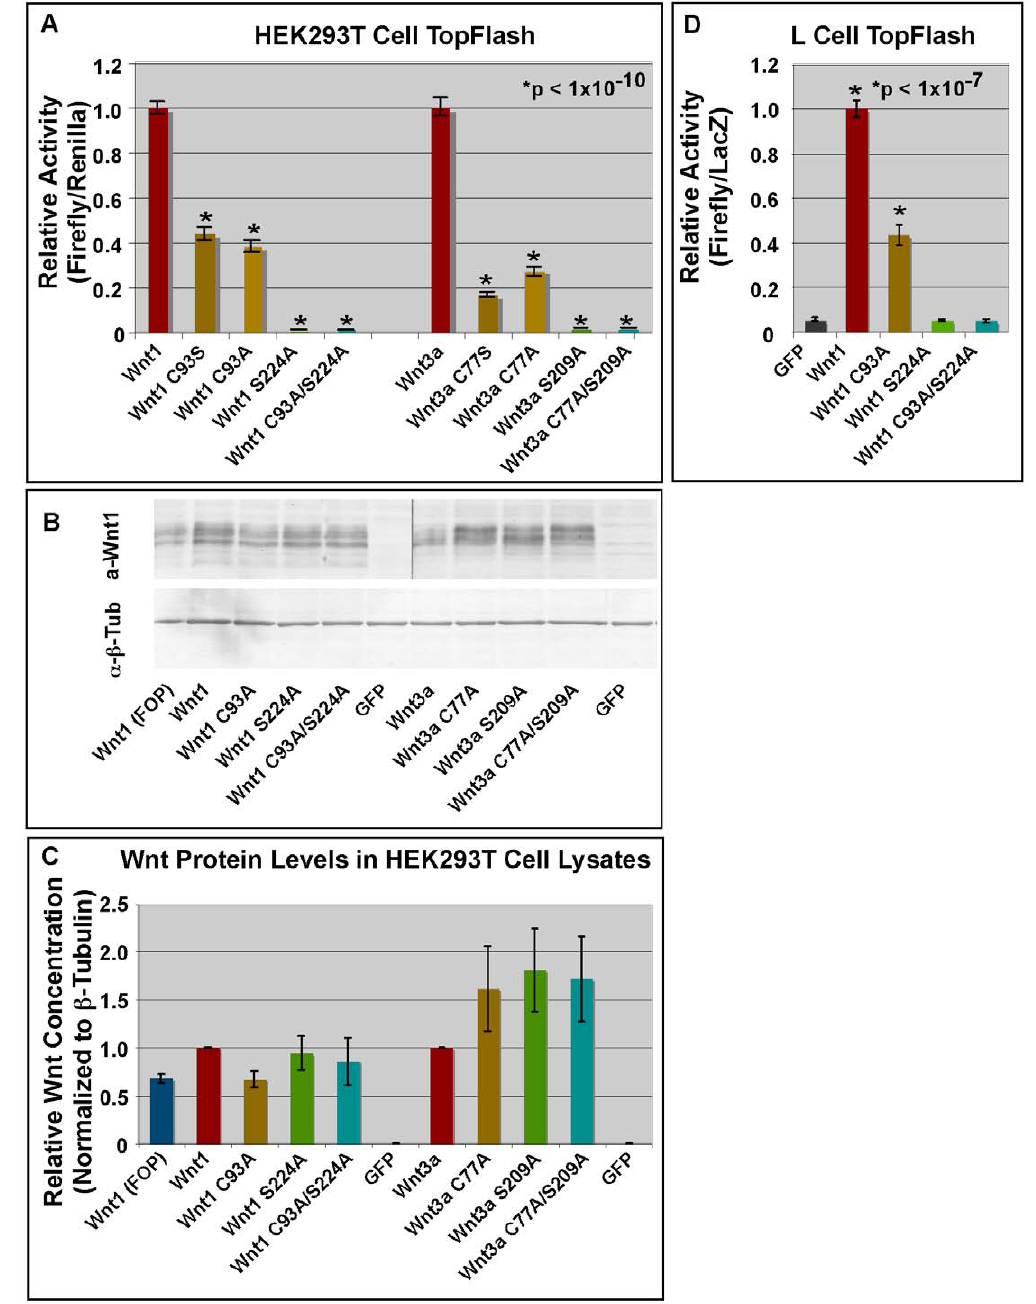
Figure 5. Wnt1 S224 is more critical than C93 for ß-catenin dependent signaling. Panel A: HEK293T cells were transfected with 8XSuperTop/FopFlash [64], renilla luciferase, and indicated pcDNA expression constructs. DNA concentrations were held constant within each series of experiments. Values shown reflect the experimental data (Firefly/Renilla) minus FopFlash (Firefly/Renilla). The relative luciferase activity of wild-type Wnt1/Wnt3a was set at 1. Single and double Wnt1/Wnt3a mutants show significantly less activity than wild-type Wnts (p , 1 6 10 2 10 ). Differences between C93S and C93A mutants are not significant nor are those between S224A and C93A/S224A. Error bars indicate standard error for at least 15 data points from 3 independent replicates. Panel B: HEK293T cells were transfected as in Panel A, lysed, subjected to SDS-PAGE, and blotted onto PVDF. Blots were probed with anti-Wnt1 or anti-ß-tubulin. Panel C: The Western blots were scanned and analyzed using NIH ImageJ. This experiment was performed 3 times. Error bars represent + / 2 standard error. Panel D: LS/L cells were then transiently transfected with constructs encoding GFP or wild-type/mutant Wnt1. As before, the relative luciferase activity of wild-type Wnt1 was set at 1. Wnt1 and Wnt1C93A show statistically significant increases in reporter activity as compared to GFP (p , 1 6 10 2 7 ) while Wnt1S224A and Wnt1C93AS224A do not. Error bars represent standard error from at least 3 independent replicates with a total of 12 data points.